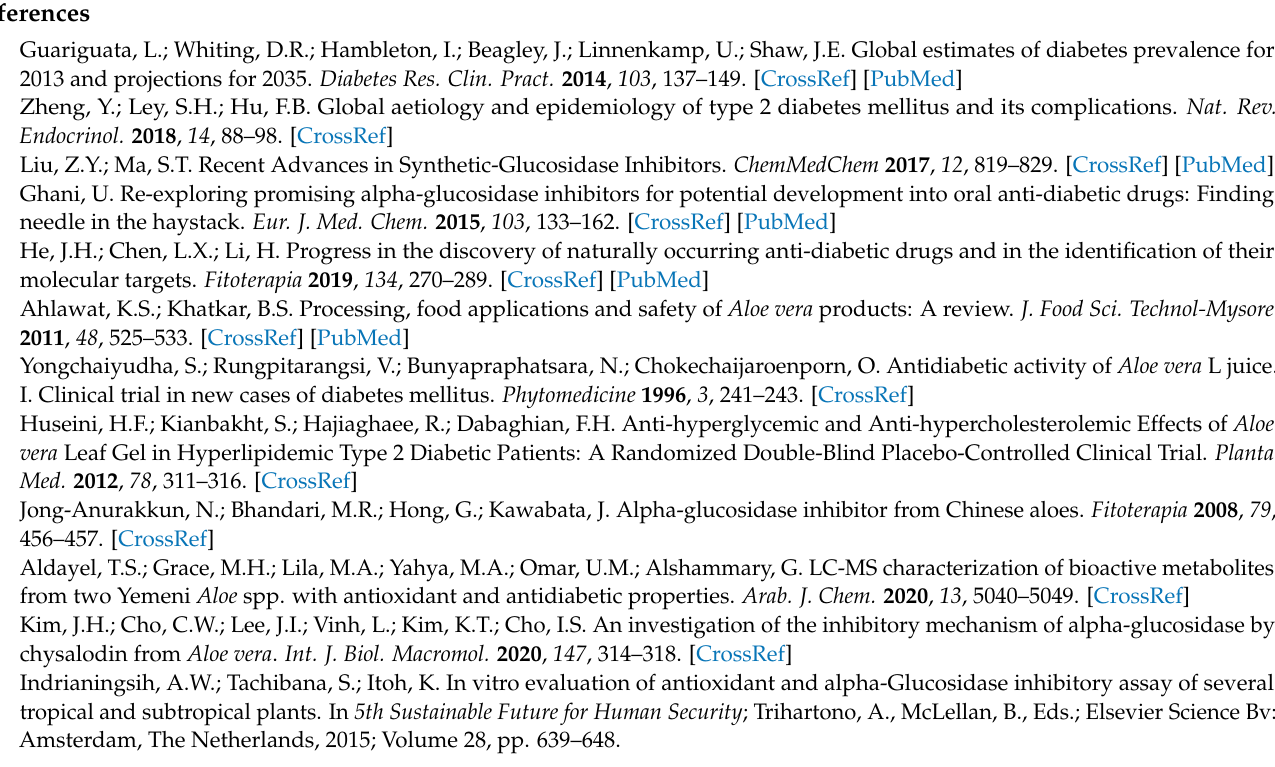
Supplementary Materials: The following are available online, Figure S1: MS spectra of 1 , Figure S2: HPLC-UV analysis of ( a ) aloenin aglycone isolated from Aloe vera ; ( b ) solution of ligands, S 5 , Figure S3: MS spectrum of 3 , Figure S4: HPLC-UV analysis of ( a ) Aloe vera extract solution, S 0 ; ( b ) aloin A isolated from Aloe vera ; ( c ) reference substance of aloin, Figure S5: MS spectra of 2 , Figure S6: HRESIMS spectrum of 2 (positive ion mode), Figure S7: HRESIMS spectrum of 2 (negative ion mode), Figure S8: 1 H-NMR (600 Hz) spectrum of 2 in methanol- d 4 , Figure S9: 13 C-NMR (150 Hz) spectrum of 2 in methanol- d 4 , Figure S10: DEPT 135 ◦ spectrum of 2 in methanol- d 4 , Figure S11: DEPT 90 ◦ spectrum of 2 in methanol- d 4 , Figure S12: HSQC spectrum of 2 in methanol- d 4 , Figure S13: HMBC spectrum of 2 in methanol- d 4